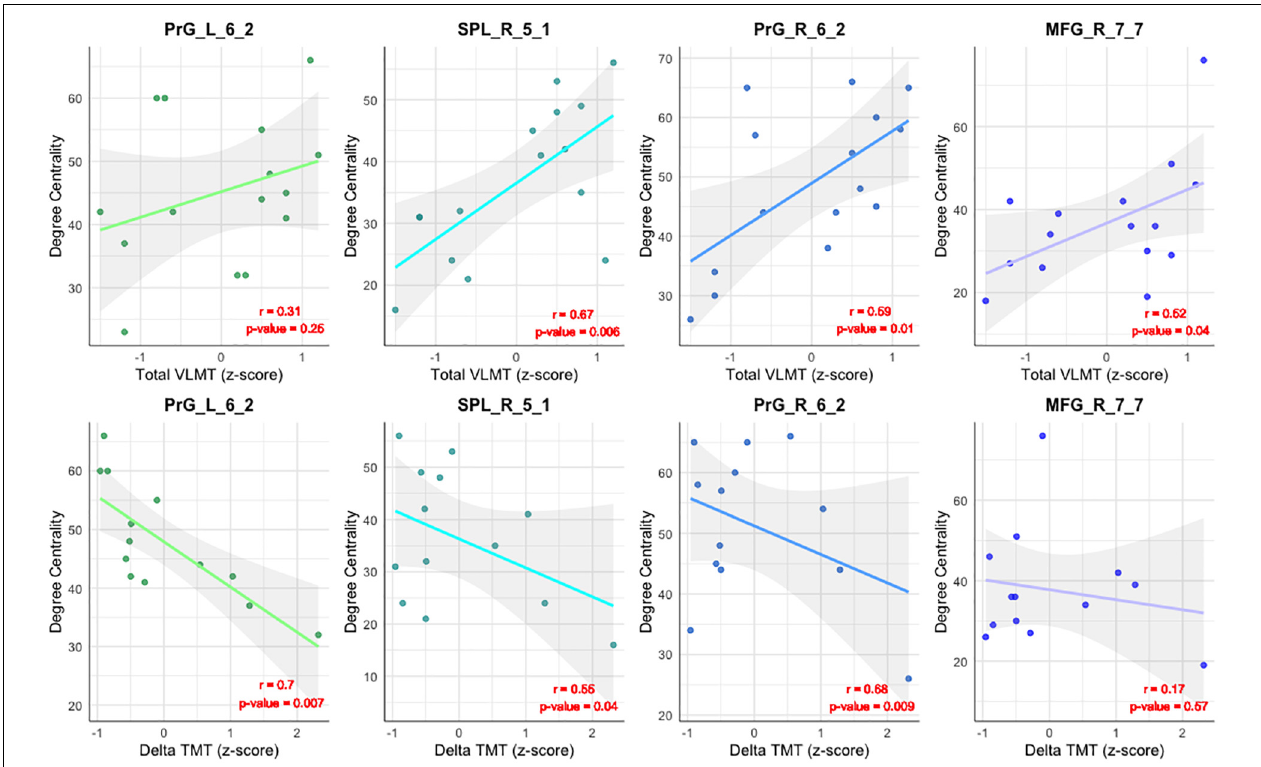
FIGURE 4 | Correlation between DC and neuropsychological tests. Illustration of the correlation between the DC of the compensatory ROIs [the right and the left precentral gyri, caudal dorsolateral area 6 (Brainnetome label: PrG_R_6_2 and PrG_L_6_2), the superior parietal lobe, rostral area 7 (SPL_R_5_1), and the right middle frontal gyrus, lateral area 10 (Brainnetome label: MFG_R_7_7)], and the total VLMT score (upper row) and Delta TMT in MCI (lower row).